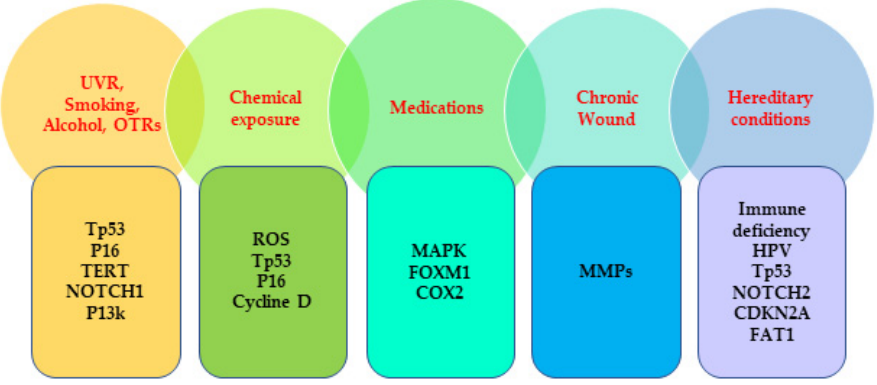
Figure 1. Commonly mutated genes associated with the risk factors of SCC. UVR, ultraviolet radiation; OTRs, organ transplant recipients; TERT , telomerase reverse transcriptase; ROS , reactive